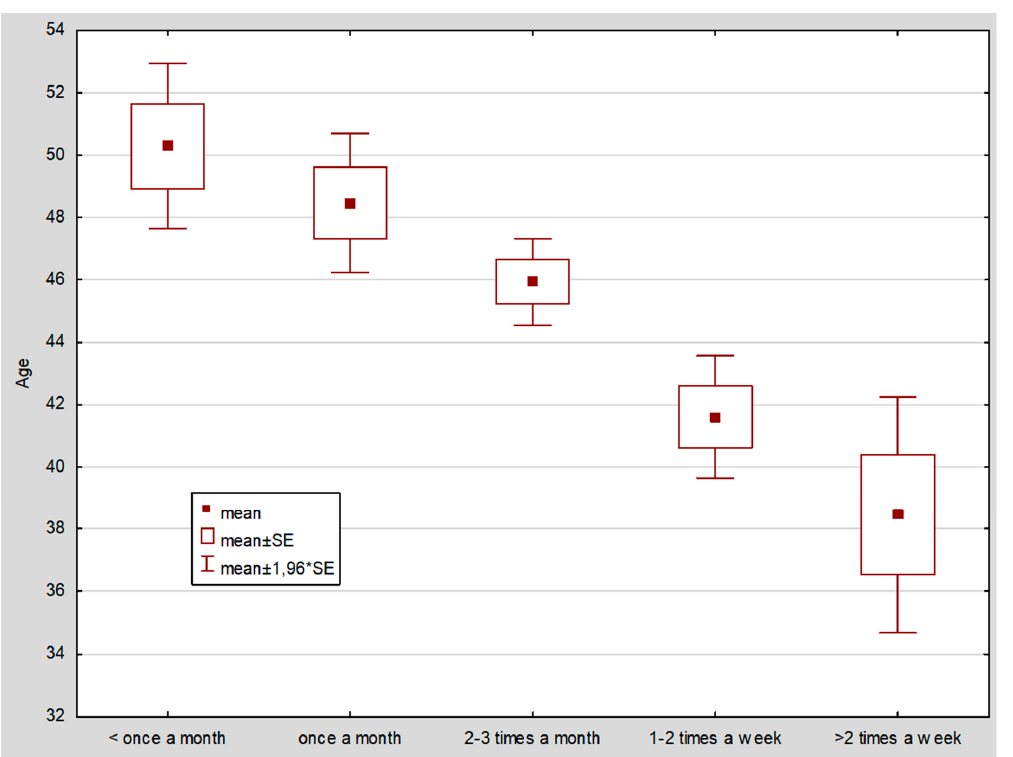
Figure 2. Age vs. purchase frequency before the COVID-19 pandemic ( p = 0.0000) Source: own elaboration.